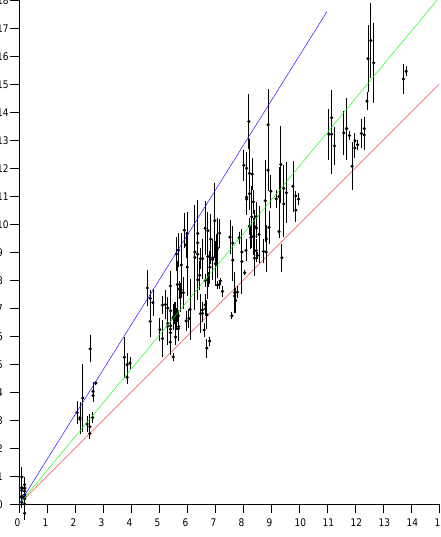
Figure 8. Scattergram of measured distances versus actual distance in wooden three-story house. Vertical axis: measured distance (meters). Horizontal axis: actual distance (meters). Red line (slope 1) is the ideal relationship; Green line (slope 1.2) is the best linear fit; Blue line (slope 1.6) is an upper extreme. The high permittivity of building materials biases the distances measured by FTM